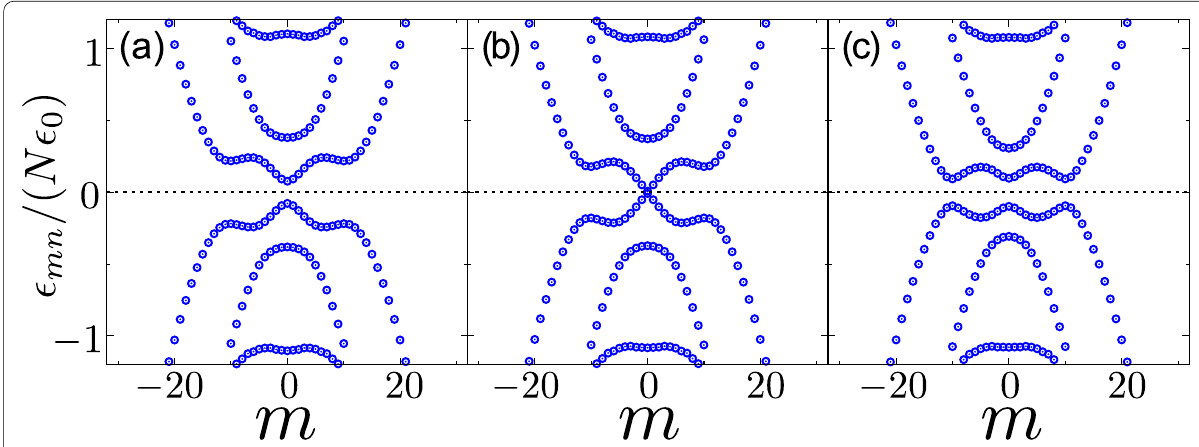
0 , and an increasing (cid:31) 0 : a =